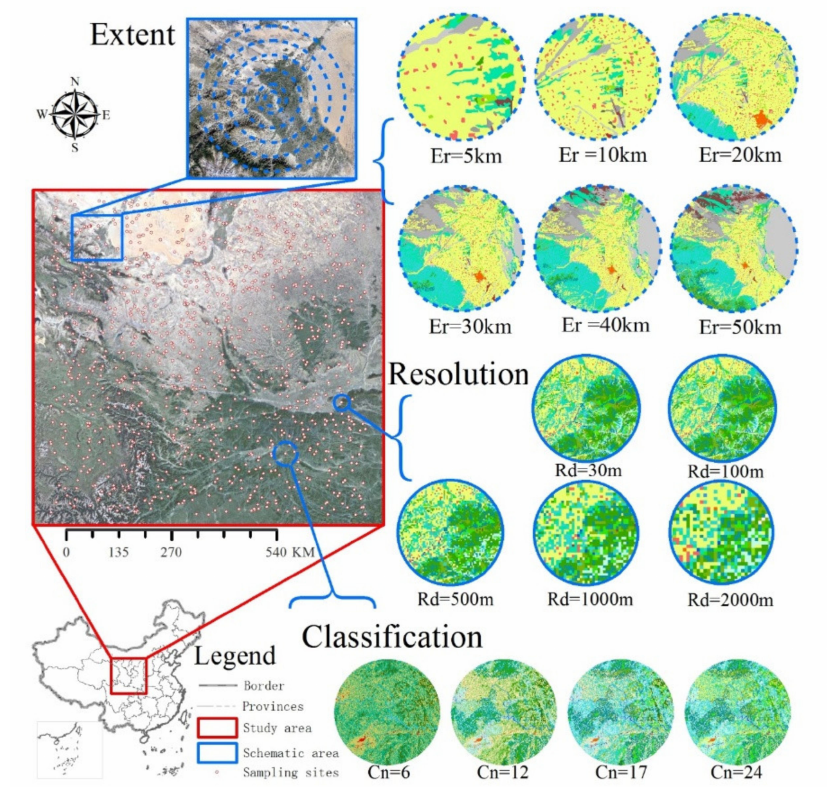
Figure 2. The study area and sampling center points of multi-scale LULC data. Er means the radius of sampling area on extent scale, Rd means the pixel size on resolution scale, Cn means the number of classes on classification